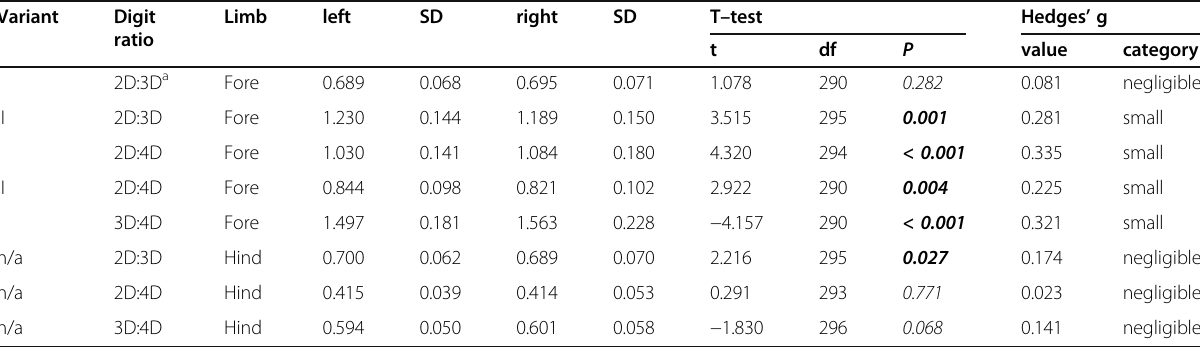
a 2D:3D in variant I corresponds to 3D:4D in variant II – for additional information, see Fig. 1; n/a Not applicable